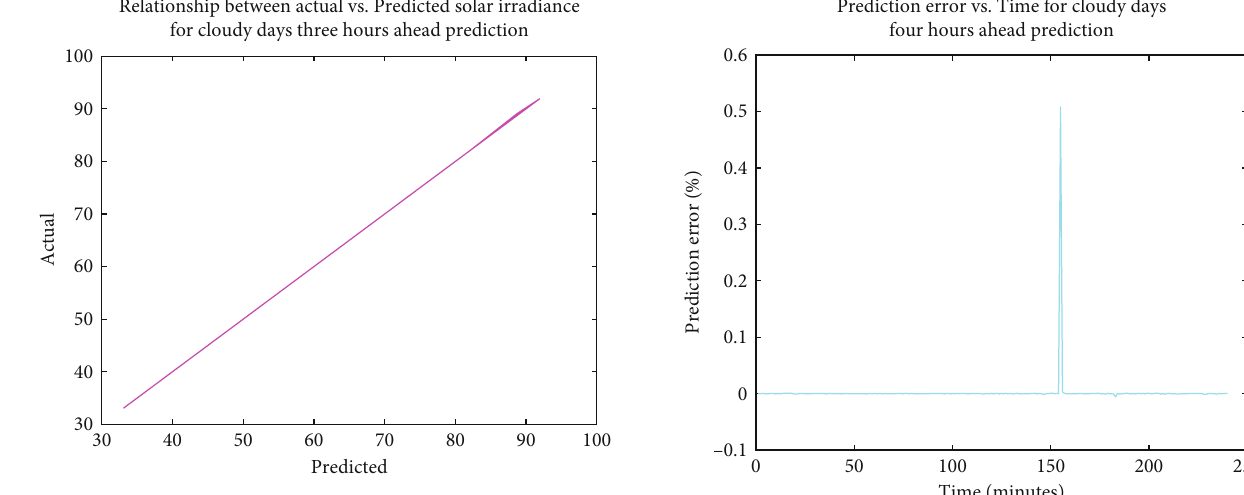
Figure 30: Relationship between actual vs. predicted solar irradiance for cloudy day three-hour-ahead prediction.